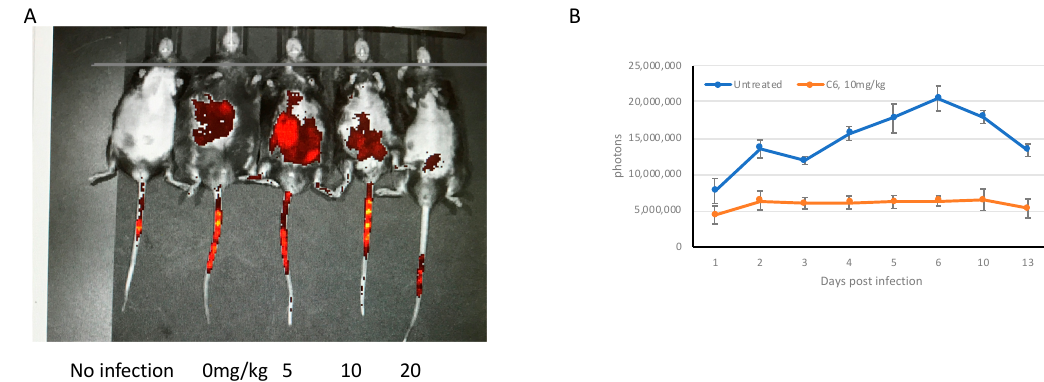
Figure 5. Fluorescence of mice infected with C. albicans GDH2346 ‐ RFP and treated with C6. ( A ). Male mBD ‐ 1 − / − mice were injected with 3.5 × 10 5 cfu C. albicans GDH2346 ‐ RFP, followed by either PBS or C6 after 2 h. Mice were visualized by IVIS over the course at day 10, and fluorescence was visualized as described. ( B ). Male mBD ‐ 1 − / − mice ( n = 5 per group) were injected with 3.5 × 10 5 cfu C. albicans GDH2346 ‐ RFP, followed by either PBS or 10 mg/kg C6 after 2 h. Mice were visualized and